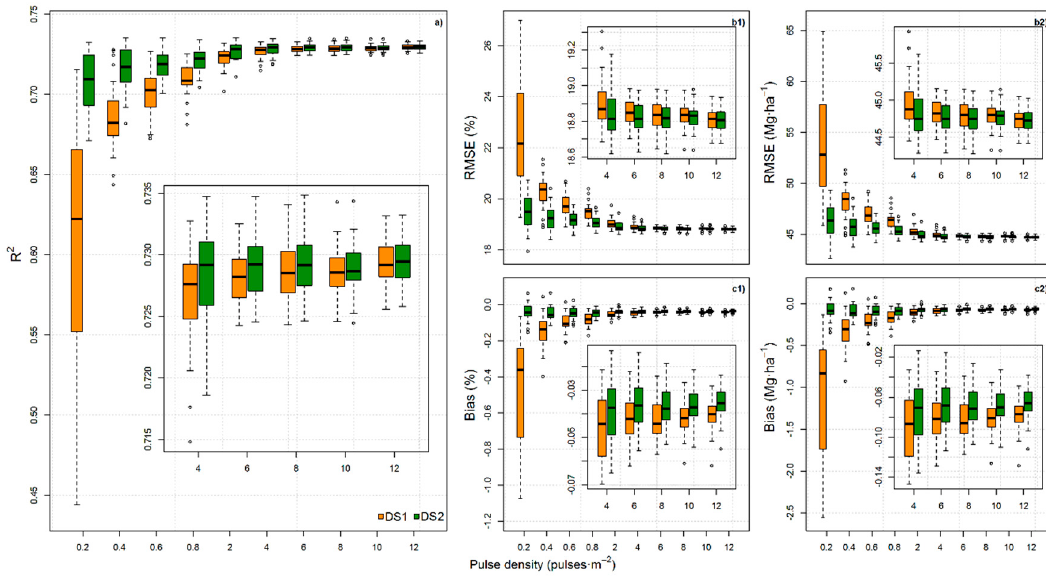
Figure 5. Boxplot of R 2 ( a ), relative ( b1 – c1 ) and absolute ( b2 – c2 ) RMSE and bias for the AGB leave- one-out cross validation – LOOCV models. DS1 (orange): DTM Scenario 1; DS2 (green): DTM Scenario 2.